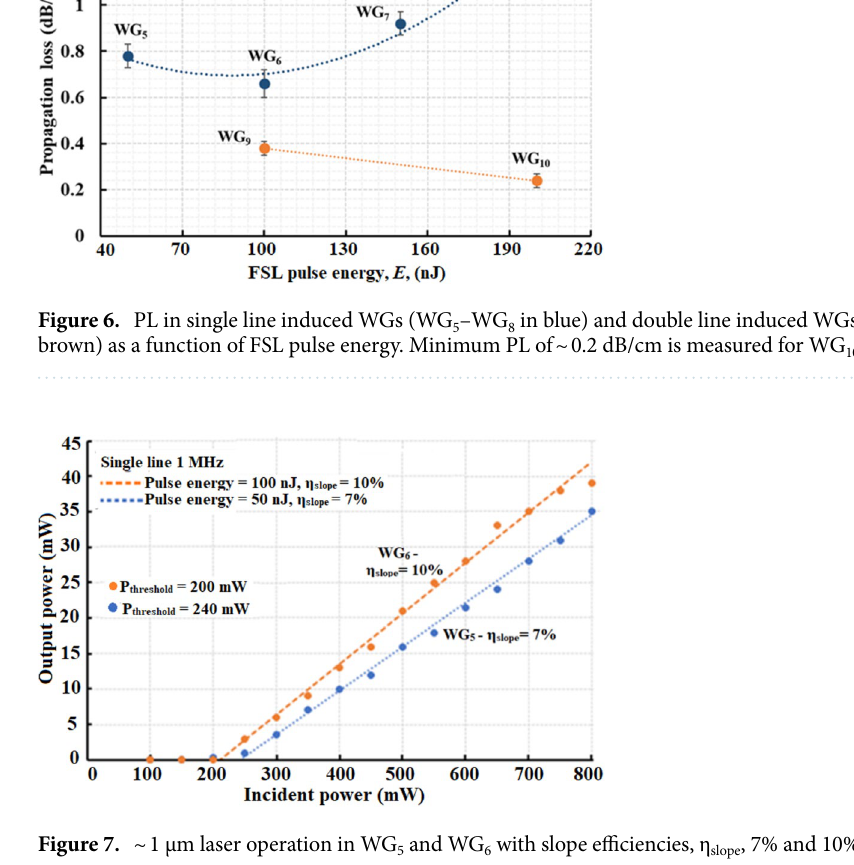
Figure 7. ~ 1 µm laser operation in WG 5 and WG 6 with slope efficiencies, η slope , 7% and 10%, respectively.